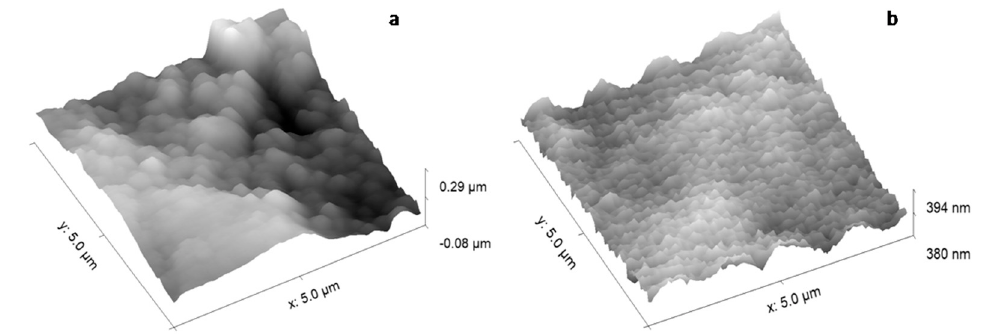
Figure 10. Tape tests for calcium phosphate coatings deposited on Ti substrates at ( a ) p = 1.2 × 10 − 2 mbarr; ( b ) p = 4.6 × 10 − 3 mbarr; and on polyprophylene substrates at: ( c ) p = 1.2 × 10 − 2 mbarr; ( d ) p = 4.6 × 10 − 3 mbarr.